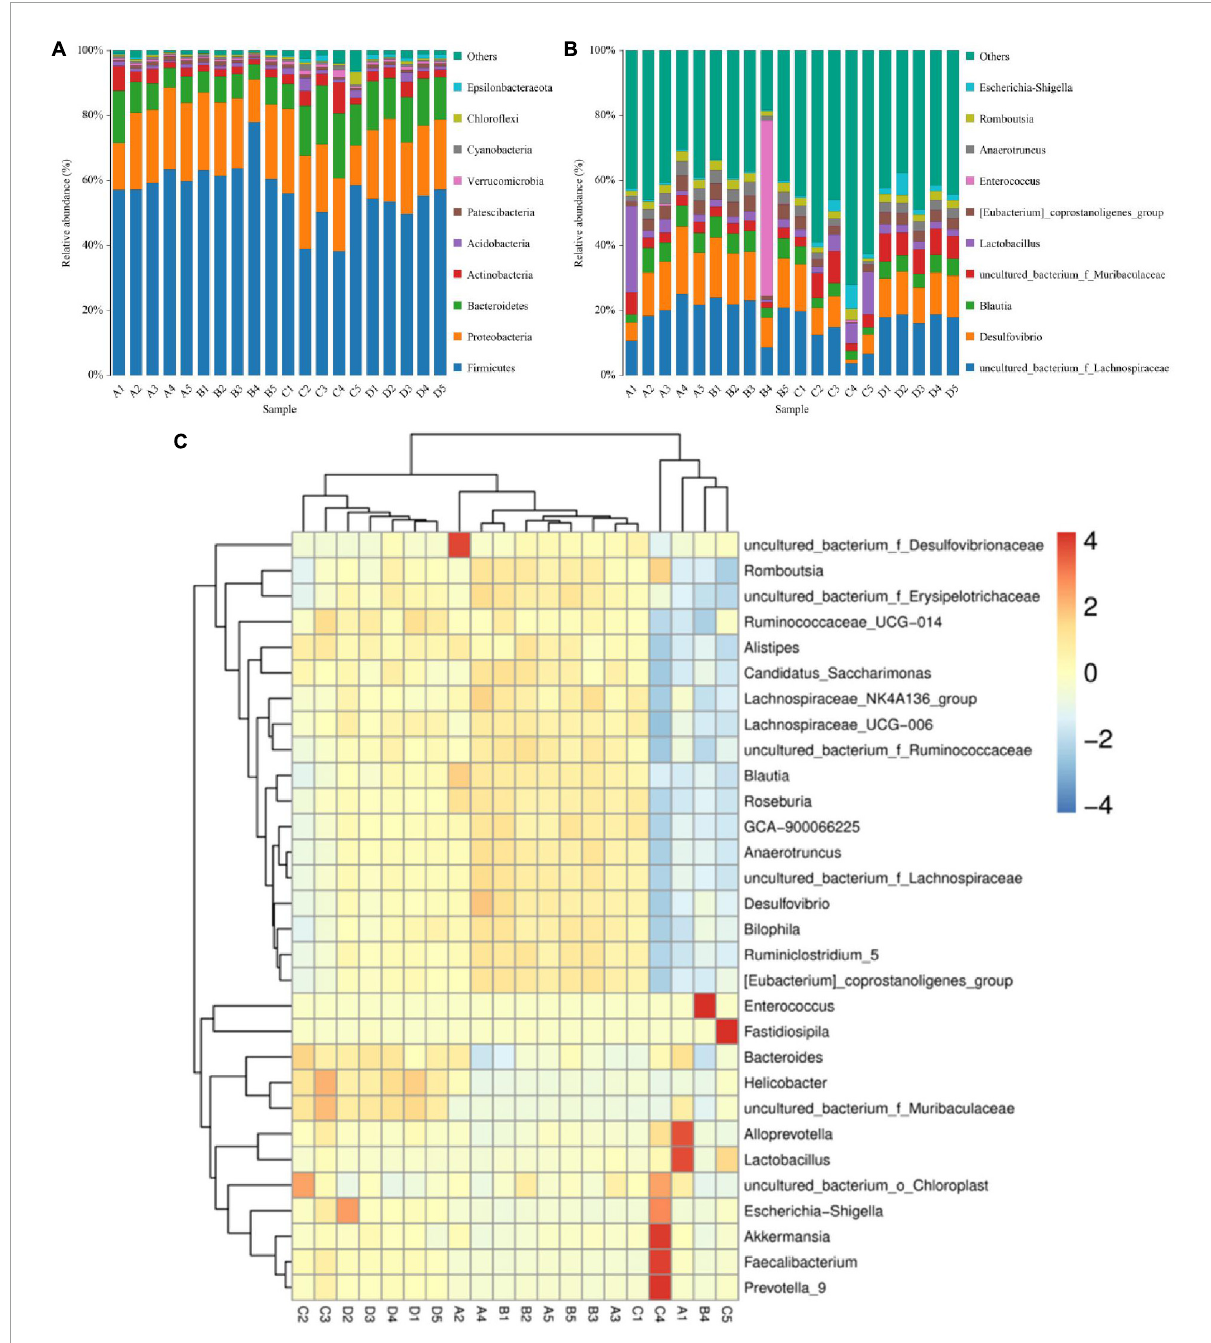
FIGURE3 The percentages of dominant bacterial taxa at the level of phylum (A) and genus (B) . The color-block m the heatmap represents the normalized relative abundance of each bacterial (C) genera.